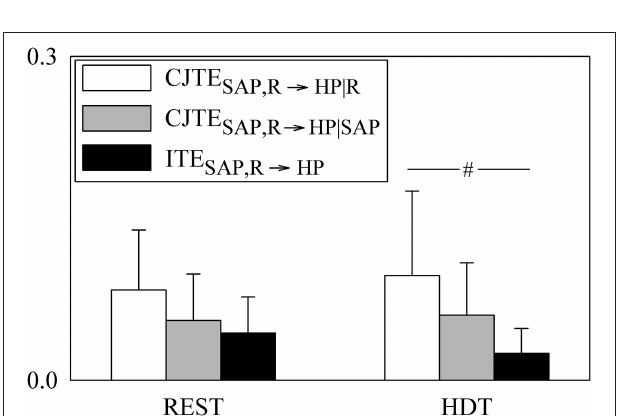
FIGURE 4 | The grouped bargraph shows the CJTE SAP ,R → HP | R (white bars), CJTE R,SAP → HP | SAP (gray bars) and ITE SAP,R → HP (black bars) assessed at REST and during HDT. CJTE SAP , R → HP | R , CJTE R , SAP → HP | SAP , and ITE SAP , R → HP are the three terms of the JTE SAP , R → HP decomposition according to Equation (21). ITE SAP , R → HP is the synergistic/redundant term of the JTE SAP , R → HP decomposition. The values are reported as mean plus standard deviation. The symbol # indicates a significant difference between indexes within the same experimental condition with p < 0.05